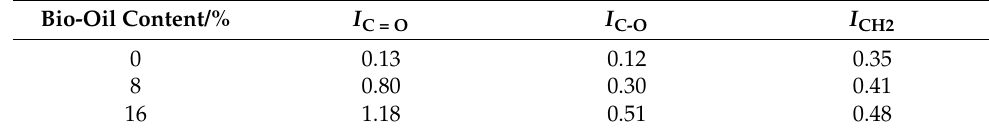
Table 6. Correlations between functional group indices and bio-oil content [27].